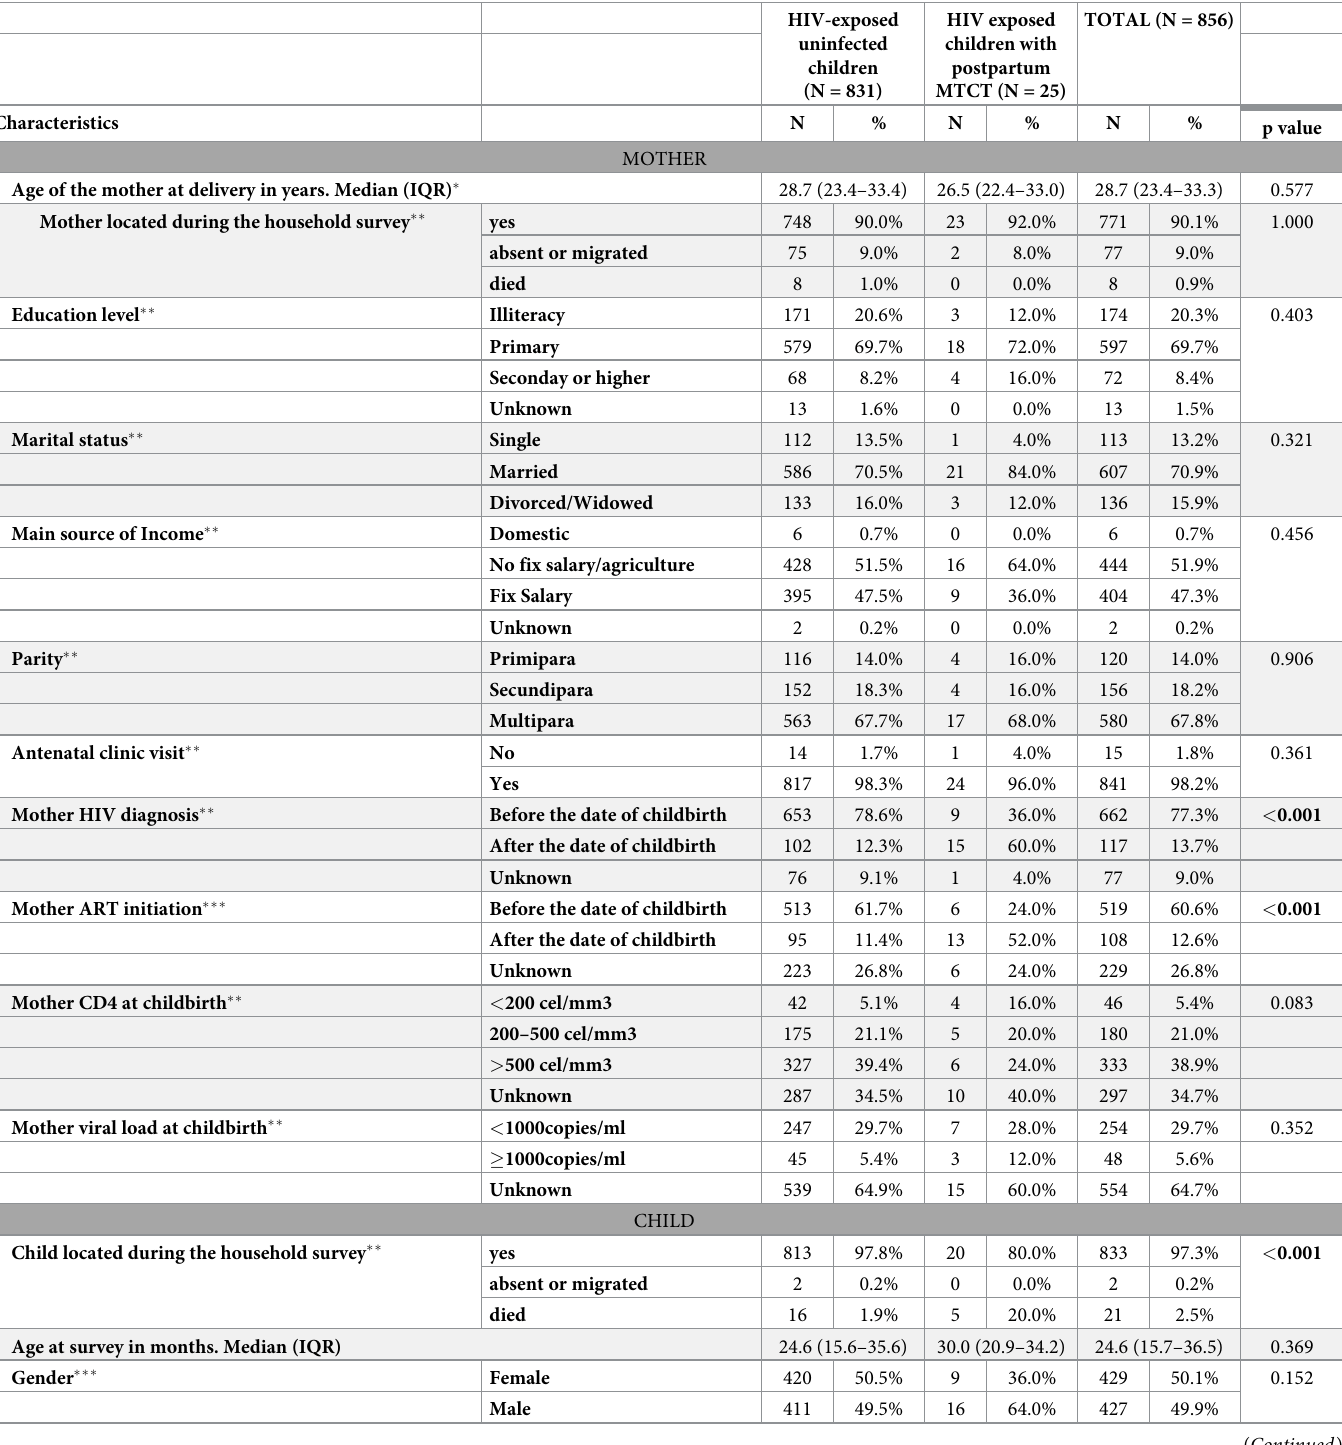
Table 2. Mother and child clinical and sociodemographic characteristics of HIV-exposed uninfected children and HIV-exposed children who acquired HIV through postpartum MTCT. N = 856. Children who never breastfed, children with HIV unknown status, children who acquired HIV through MTCT during pregnancy and deliv- ery and HIV positive children with no information on time of HIV acquisition were excluded from this